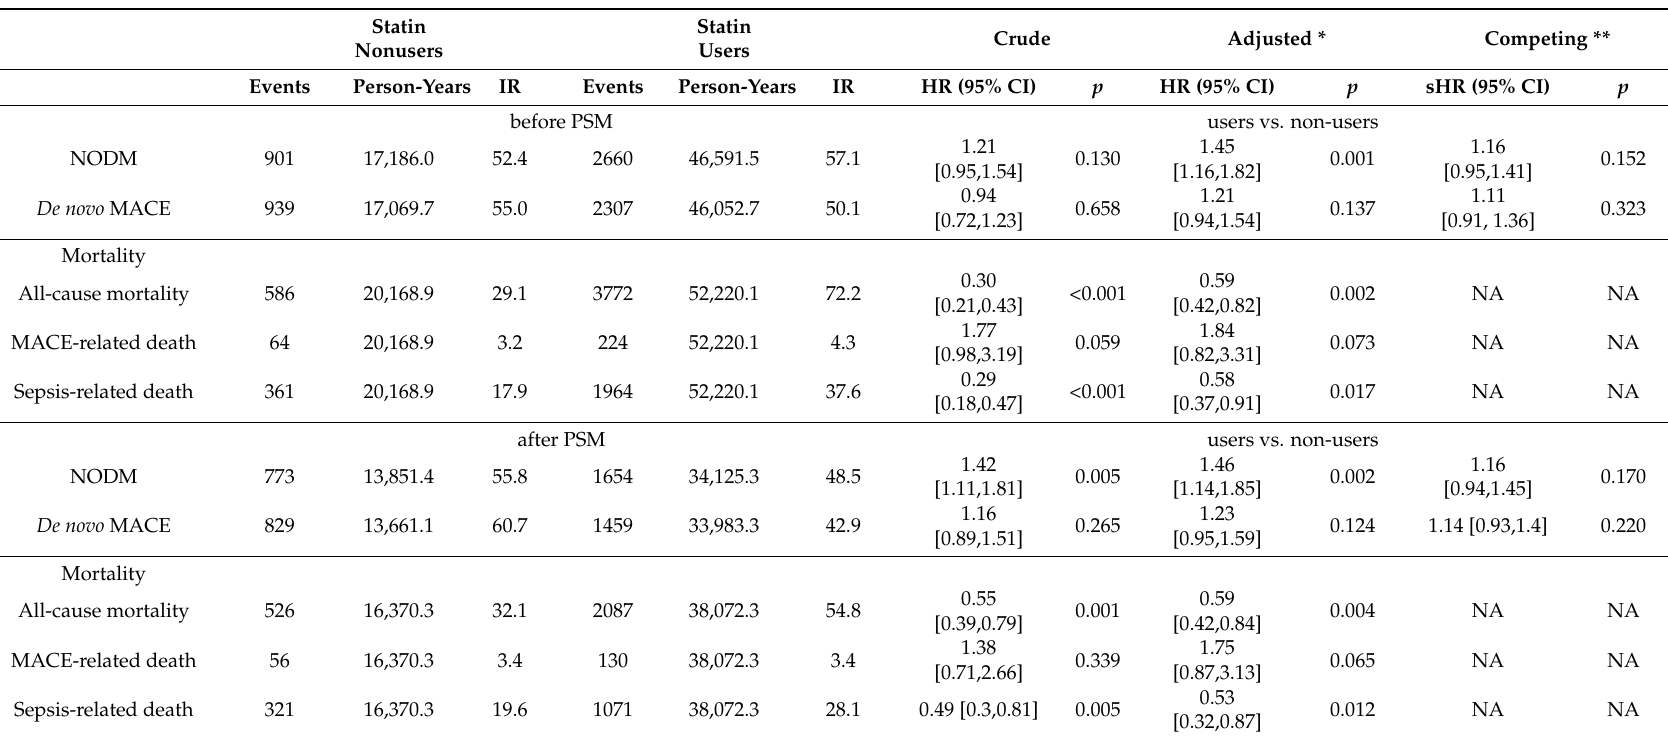
Table 2. Risks for NODM, de novo MACE, all-cause mortality, MACE- and sepsis-related death before and after propensity score